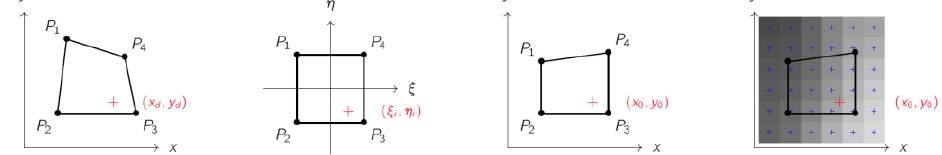
Fig. 3. Principle of finite element based image deformation